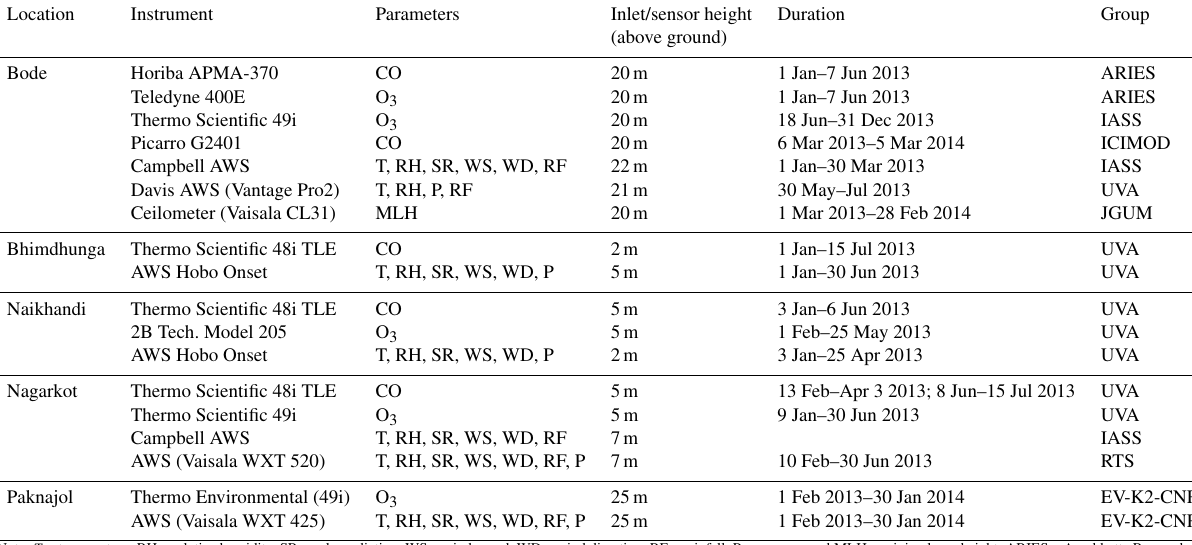
Table 2. Details of the instruments deployed at different sites during the observation period during January 2013–March 2014 in the Kath- mandu